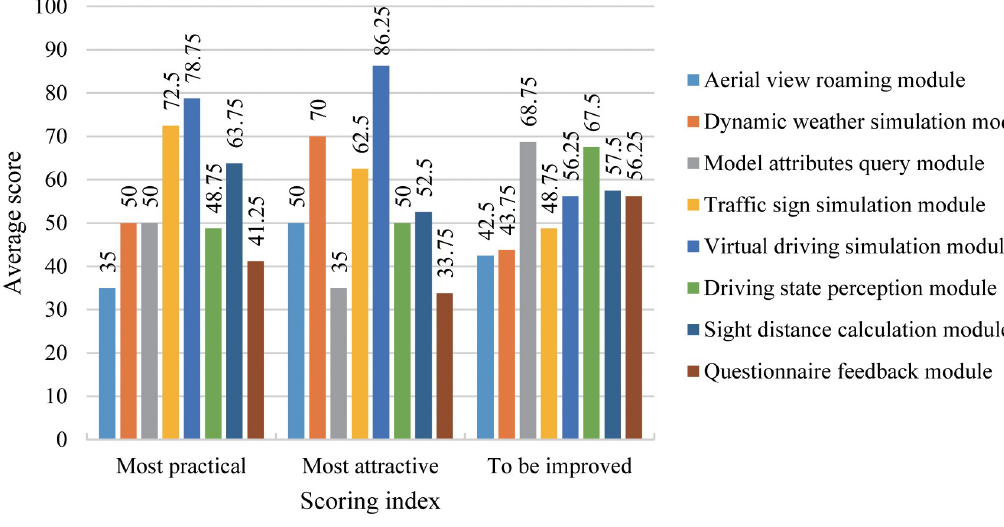
Fig 15. Survey result of modules’